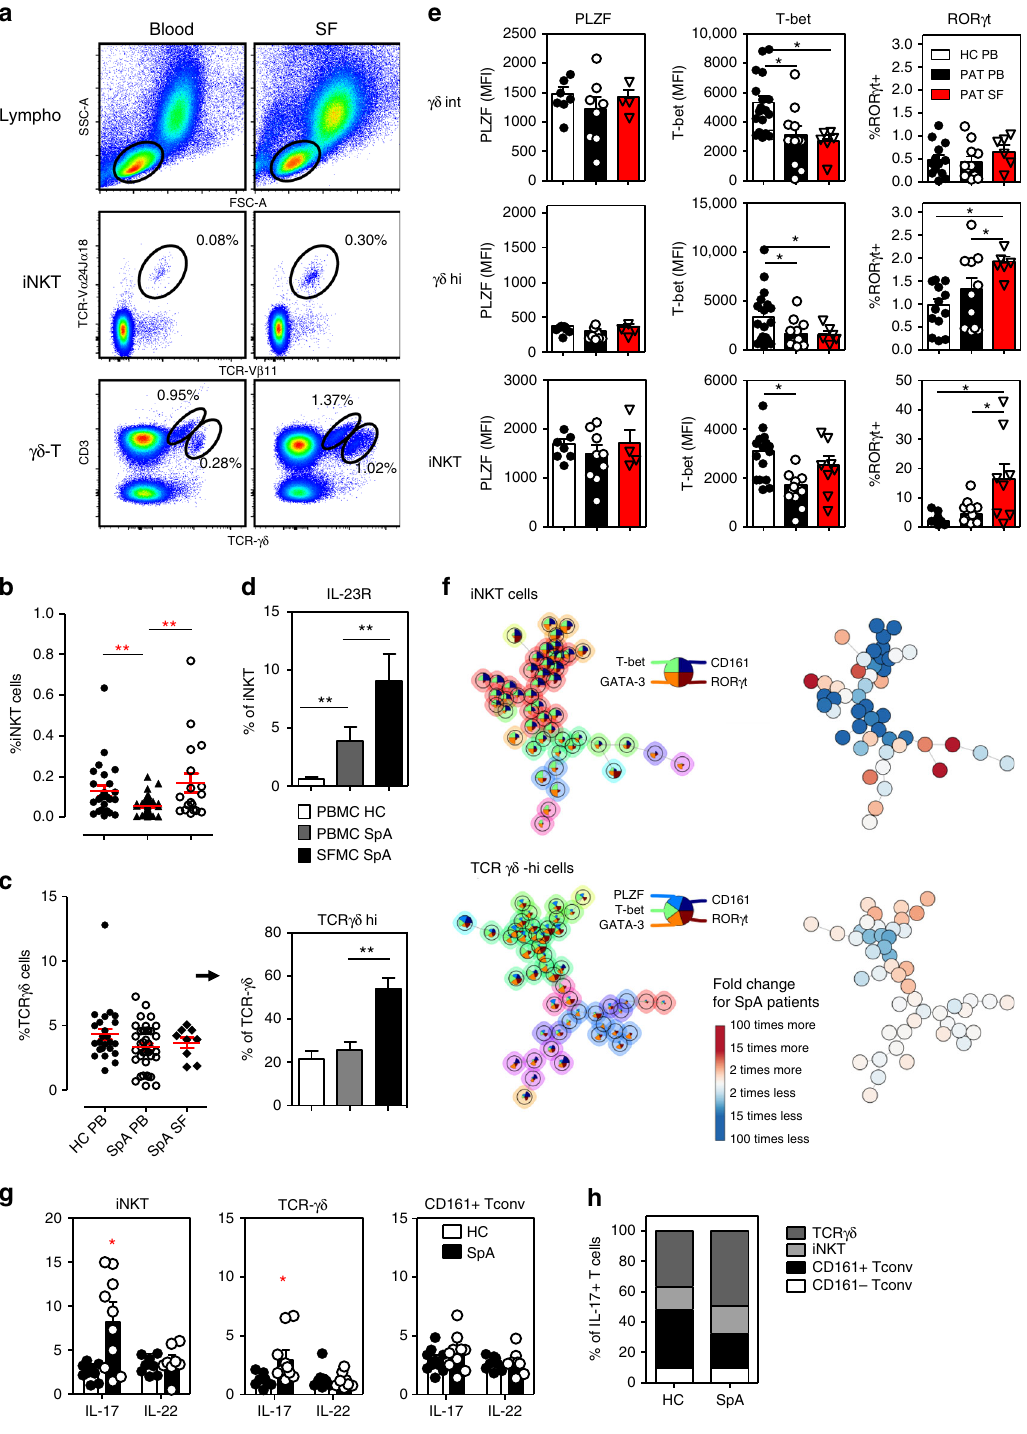
age matched healthy controls (Fig. 3a, b; HC 0.130 ± 0.025% vs. ANOVA). These alterations in iNKT and γδ -T cells were also SpA 0.051 ± 0.008%; p < 0.01, ANOVA). By contrast, iNKT cell re fl ected in patient derived synovial tissue samples (in fl amed numbers were increased in the SF samples of these patients knee) (Supplementary Fig. 3). Moreover, there was also a sig- (0.168 ± 0.047%; p < 0.01 as compared to SpA blood). Frequencies ni fi cant increase in the number of IL-23R + iNKT and γδ -T cells in the joint compartment of SpA patients (Fig. 3d; iNKT: blood of γδ -T cells were not signi fi cantly reduced in circulation of SpA 4.3 ± 1.2% vs. SF 9.0 ± 2.2%; Fig. 5c γδ -T: blood 4.6 ± 1.7% vs. SF patients compared to healthy controls (Fig. 3c; HC 4.31 ± 0.41% 17.9 ± 13.9% of γδ -T cells; both p < 0.01, ANOVA). vs. SpA 3.34 ± 0.27%; p > 0.05, ANOVA). But curiously, in SF of A hallmark of innate-like T cells such as iNKT and γδ -T cells is SpA patients the prevalence of especially the TCR γδ -hi subset was their functional plasticity which is reminiscent, and may even remarkable augmented compared to peripheral blood (Fig. 3c; exceed, that of conventional CD4 T cells 3 . We therefore analyzed SpA blood 25.8 ± 3.6% vs. SF 54.3 ± 4.7% of γδ cells; p < 0.01, NATURE COMMUNICATIONS| (2019) 10:9